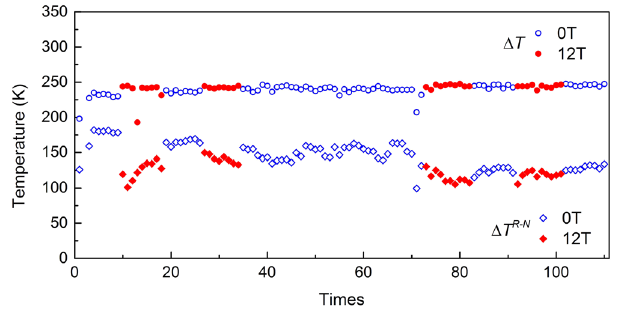
Figure 3. Undercoolings of Co 76 Sn 24 near eutectic alloy measured in and without 12 T homogeneous magnetic field during cyclic heating process.